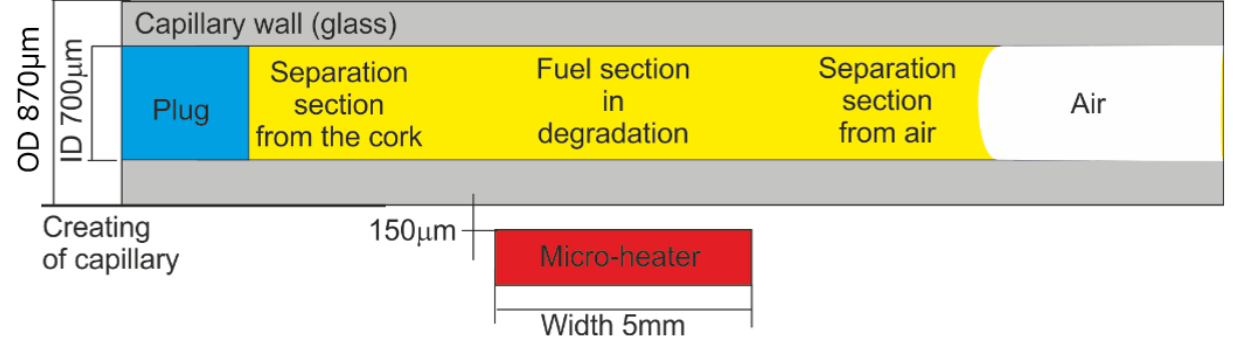
Figure 4. The idea of diesel fuel local section exclusive degradation with